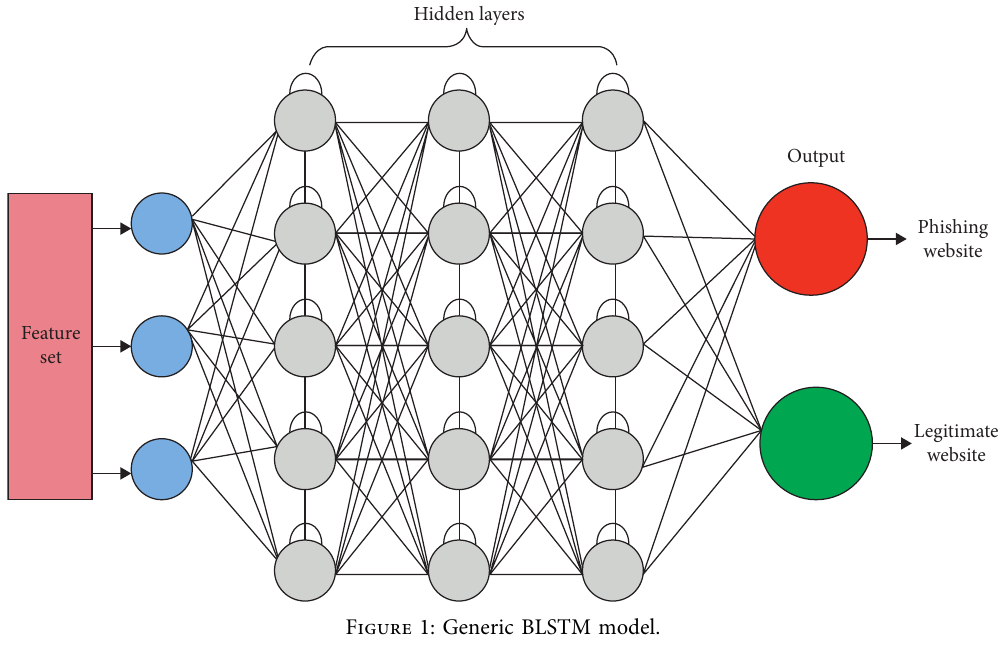
Figure 1: Generic BLSTM